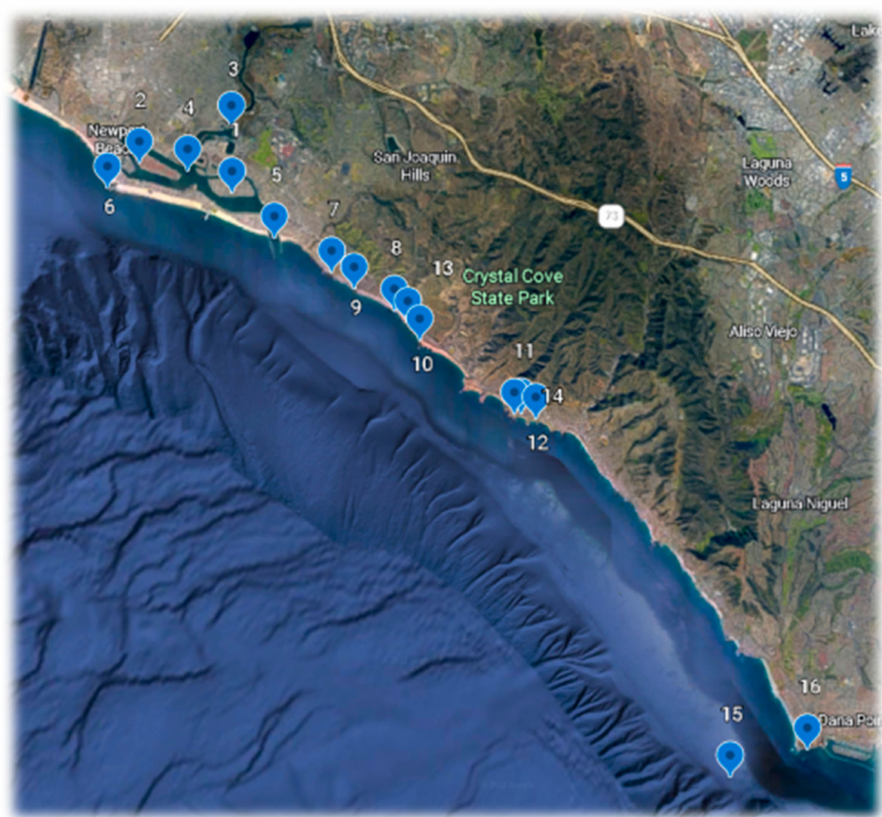
Figure 1. Map of collecting sites listed in Table